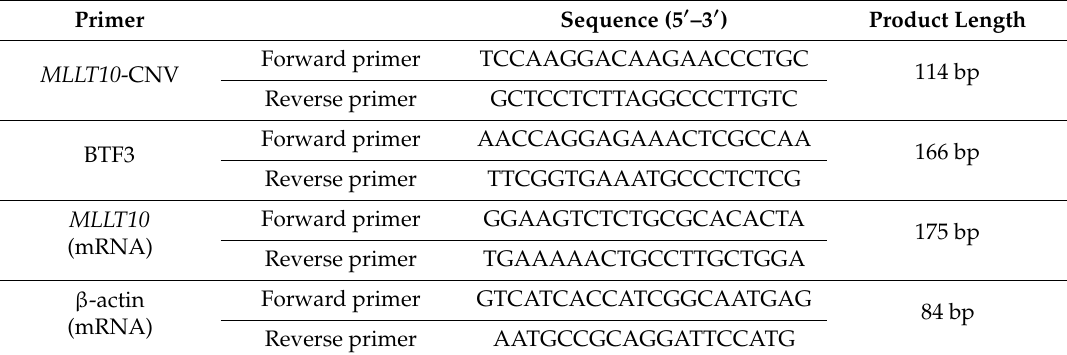
Figure 2. Blue boxes represent exons. The copy number variation region of the MLLT10 gene comprised the fifth exon and the sixth exon. Table 1. Primer information in CNV and expression